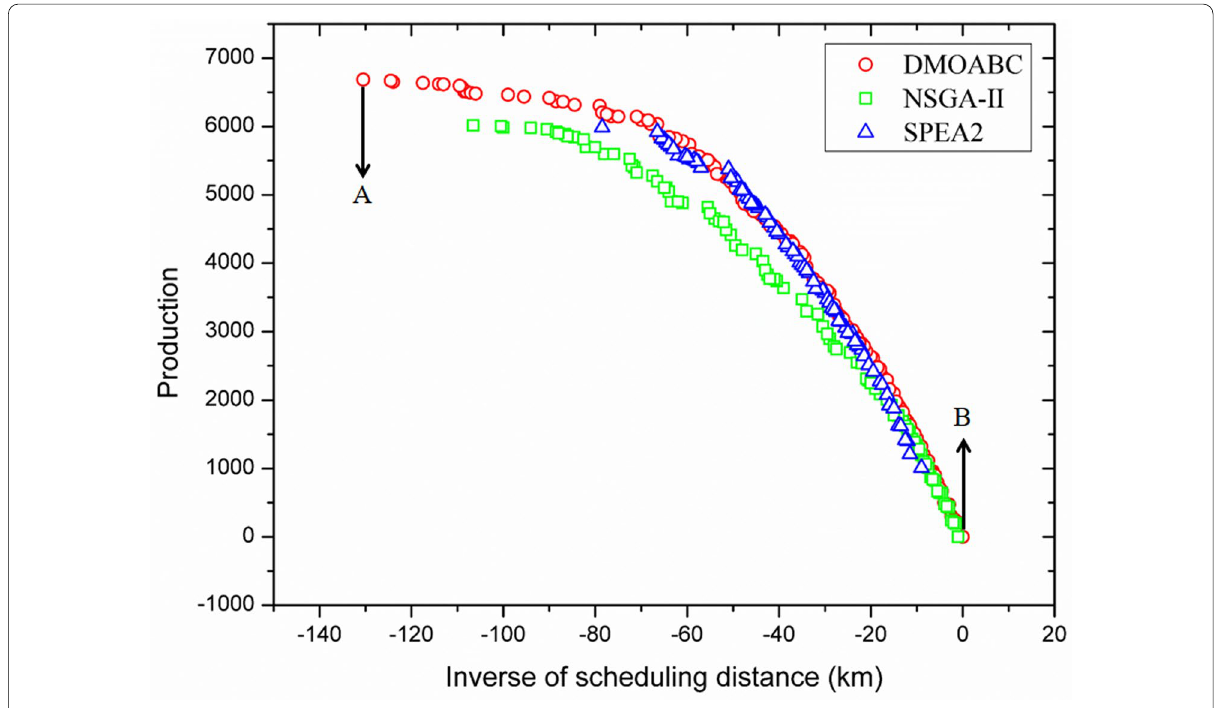
Figure 5 Pareto front solutions of the case